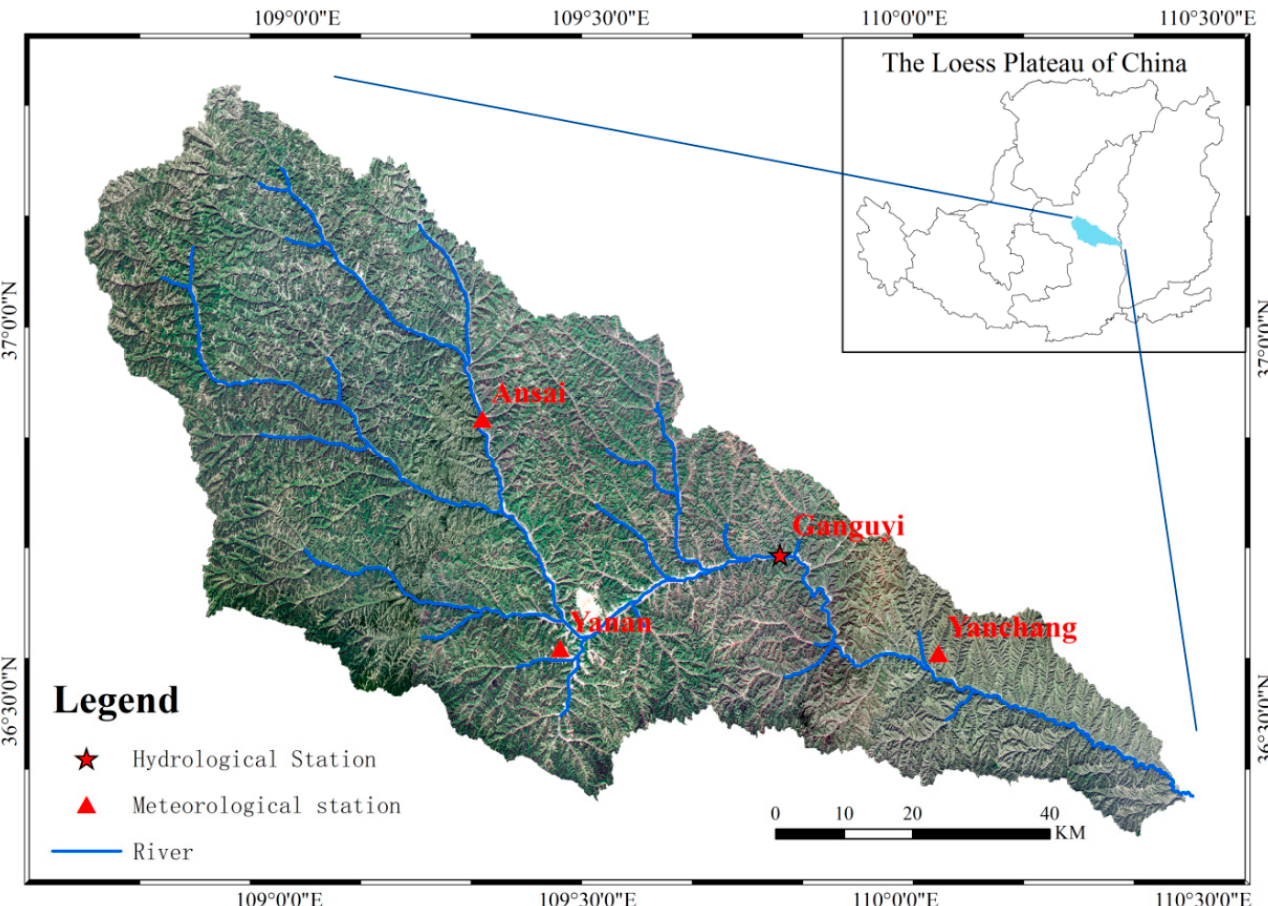
Figure 1. Basic information map of the YanHe Watershed.